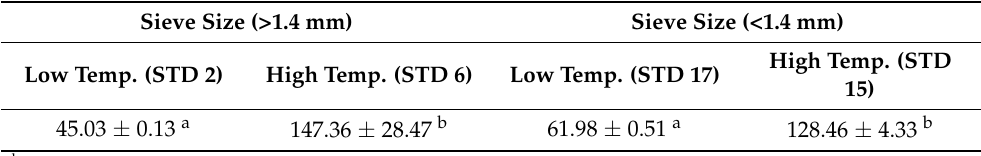
a,b indicates the significant changes among the